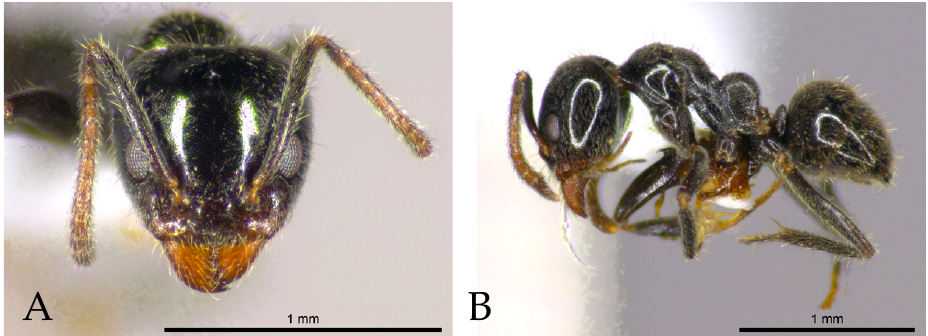
Figure 9. Head and lateral views of Anonychomyrma sp. E ( A , B ).